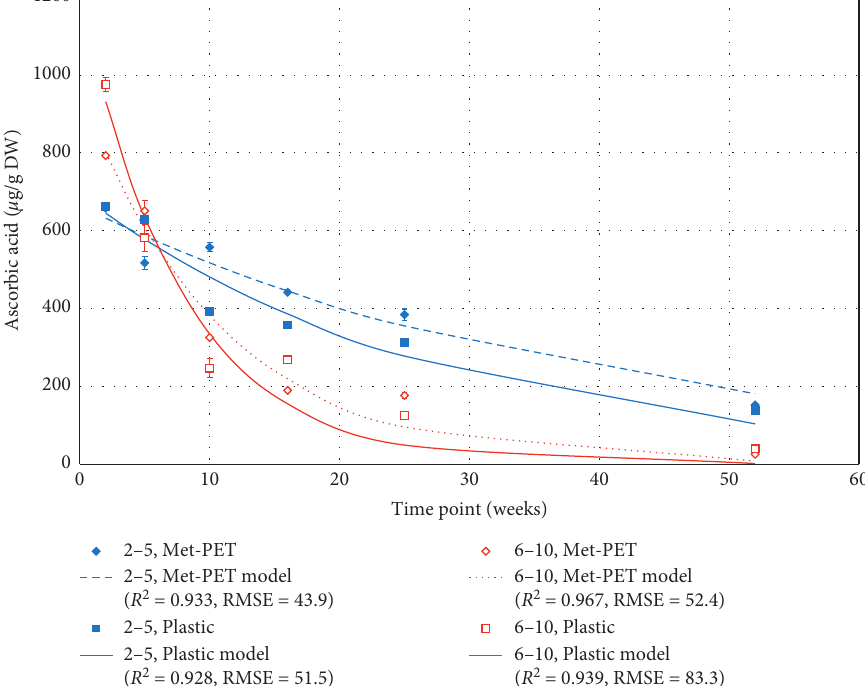
Figure 4: Mean levels of ascorbic acid of the persimmon chips over the 1-year course of the storage study, overlaid with best-fit exponential decay (1 st -order kinetics) curves. Each error bar is constructed using 1 standard error from the mean. DW � dry